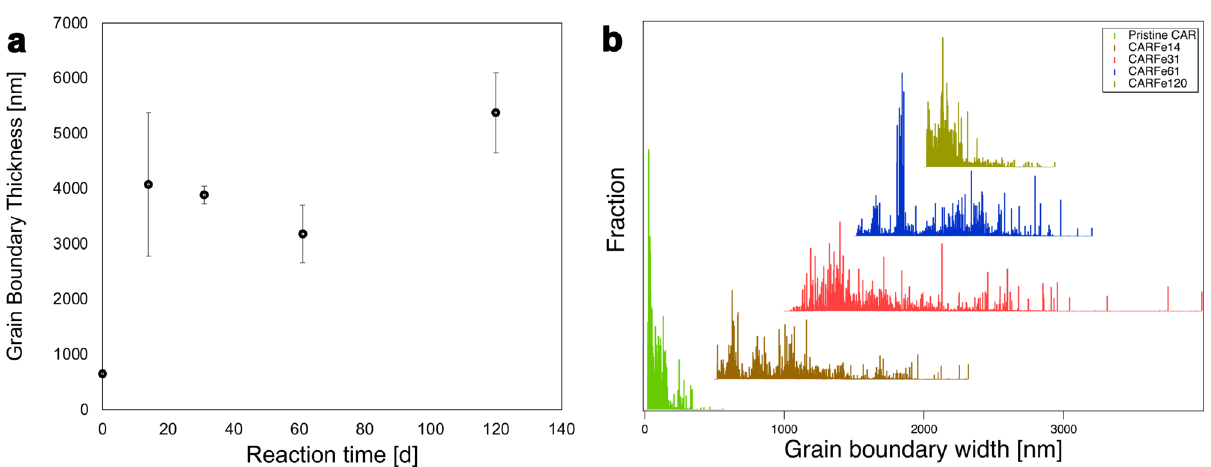
Figure 8. ( a ) Average grain boundary width in nm as a function of reaction time in days measured by AFM. ( b ) Grain boundary thickness distribution determined by SEM image analysis via local thickness analysis. CAR Reference before reaction is plotted in green, CAR reacted for 14 days in brown, CAR reacted for 31 days in red, CAR reacted for 61 days in blue and CAR reacted for 120 days in light percentage of Fe incorporated into calcite, which is consistent with the CaCO 3 -FeCO 3 phase diagram at 200 °C 14 . EDS was not able to detect Fe incorporated into CAR, which indicates that its concentration is likely below several hundreds of ppm (approximated EDS detection limit). Siderite rims on dolomite grains were also observed in a previous study on glauconite carbonation during sedimentary diagenesis 23 .